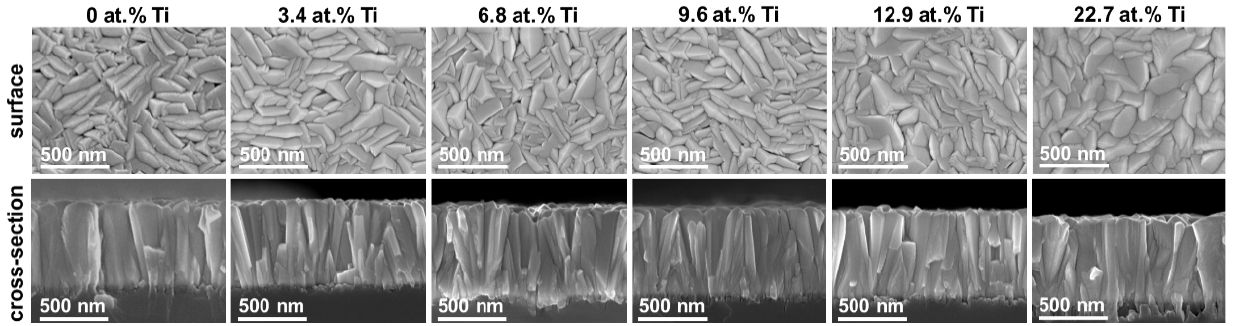
Figure 3. Surface and cross-section SEM images of the WTi alloys films as a function of Ti concentrations.